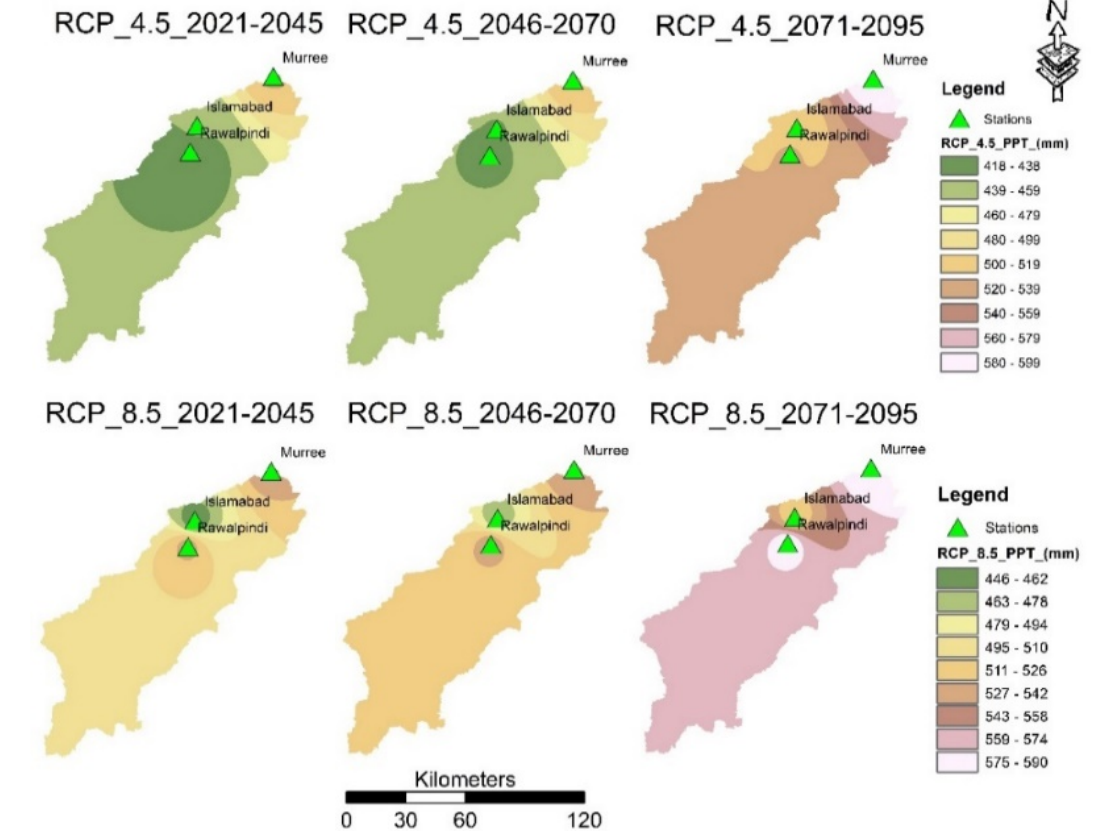
Figure 7. Spatial distribution of precipitation data in the SRB for early, mid, and late century under both RCP-4.5, and RCP-8.5.